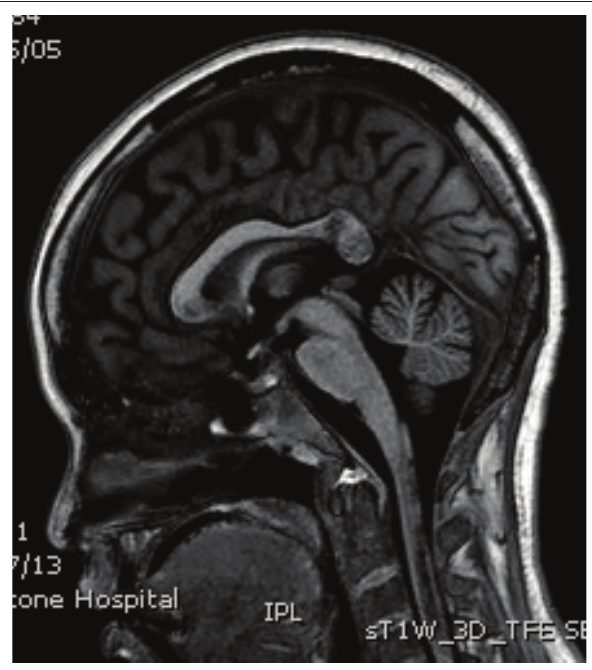
FIGURE 3: Sagittal T1-weighted image depicting hypointensity in the splenium and cervical spinal